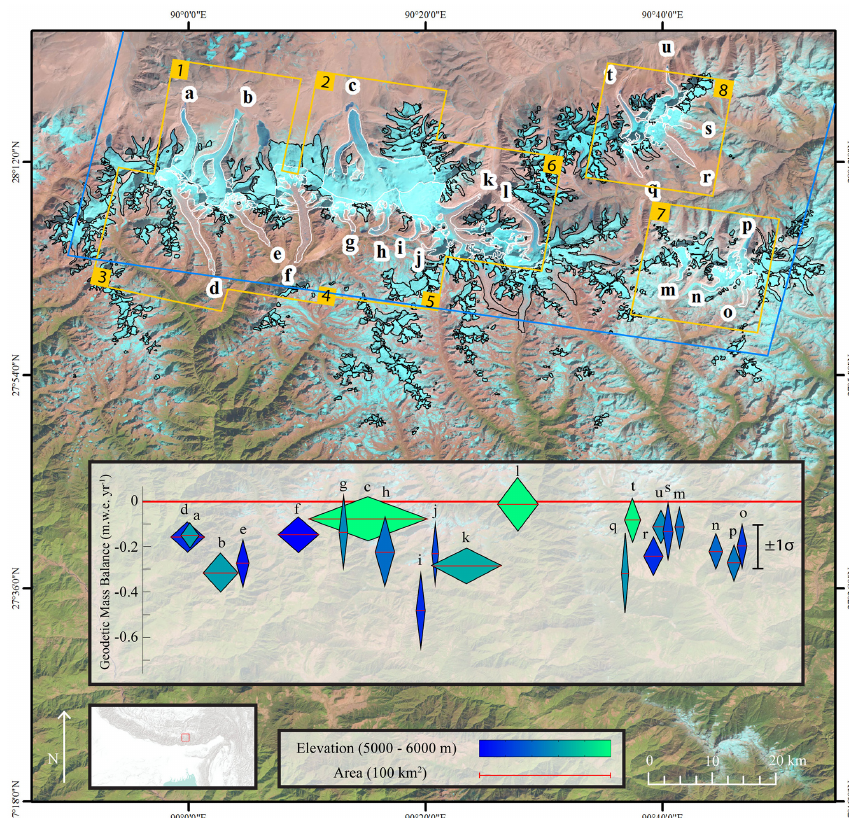
Figure 2. Landsat 8 image showing study region located in the eastern Himalayas and Tibetan Plateau. Black outlines identify all glaciers in the region, while white outlines denote glaciers used in this study, identified by letters a–u. Glacier outlines were downloaded from the ICI- MOD mountain geoportal. Orange outlines indicated extent of extracted 1974 Hexagon DEMs; blue line indicates extent of the 2006 ASTER DEM. Inset: annual geodetic mass balances for selected glaciers during the 1974 to 2006 period (2006 ASTER DEM minus 1974 Hexagon DEMs), where each diamond represents a glacier. Central red lines are geodetic mass balances for each glacier in mw.e.yr − 1 (meters water equivalent per year). Diamond widths are proportional to total glacier area, heights indicate ± 1 standard error (SEM) uncertainty, and colors specify mean glacier elevations. Thick red line indicates zero